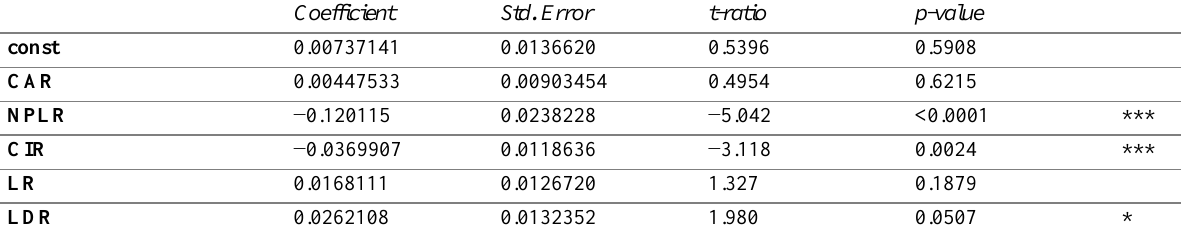
Table 5: Fixed Effects Model: ROA is the dependent variable